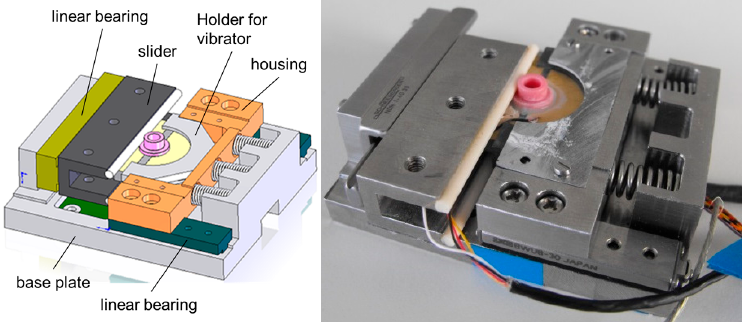
Figure 14. Perspective views (3D CAD drawing and photo) of the test linear motor. The piezoelectric vibrating element was placed between two identical holders.